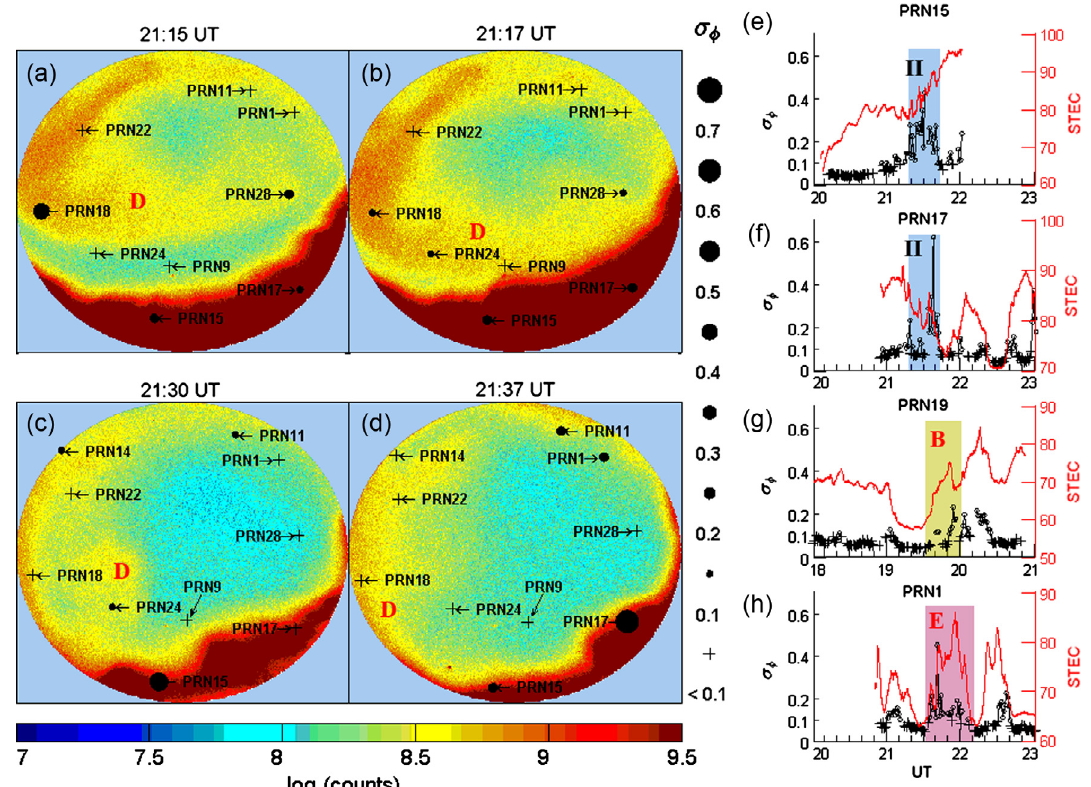
Fig. 3. The same format as Figure 2. (a–d) Patch D moved southward and entered into the auroral zone (red colored regions) to become into an auroral blob. Phase scintillations were intensified when patch D passed through the LOS of GPS satellites. (e, f) The shaded regions correspond to the time period when the newly formed blob passed through the LOS of PRN15 and PRN17. There is no data after 22:00 UT in (e) and before 20:54 UT in (f) because PRN15 and PRN17 were out of the FOV at that time. (g, h) The shaded regions correspond to the time periods when patches B and E passed through the LOS of PRN19 and PRN1, respectively. PRN1 was out of the FOV before 20:49 UT and no data was recorded for that time in